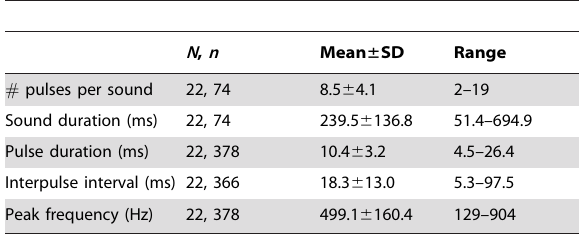
Table 1. Summary of characteristics of courtship sounds produced by dominant male Astatotilapia burtoni .